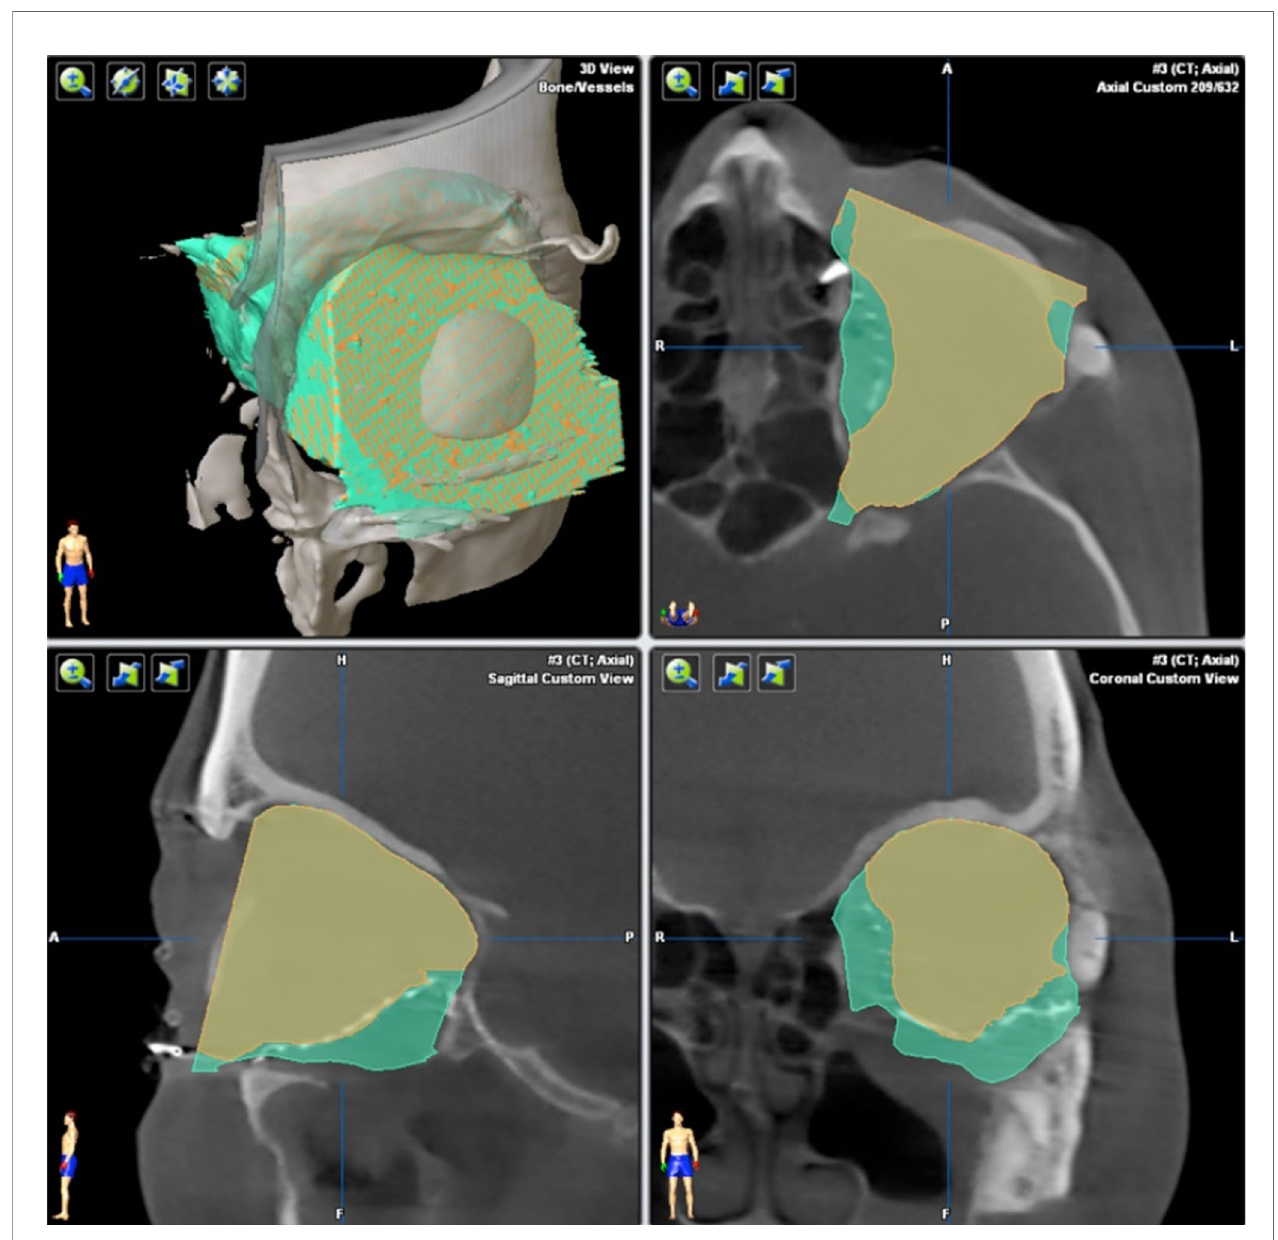
FIGURE 7 | Calculation of orbit volume. Orbital cavity algorithm calculates the orbit volume not only within the bony boundaries (green), but also on the adjacent orbit 3D mesh (yellow). The volume calculation works